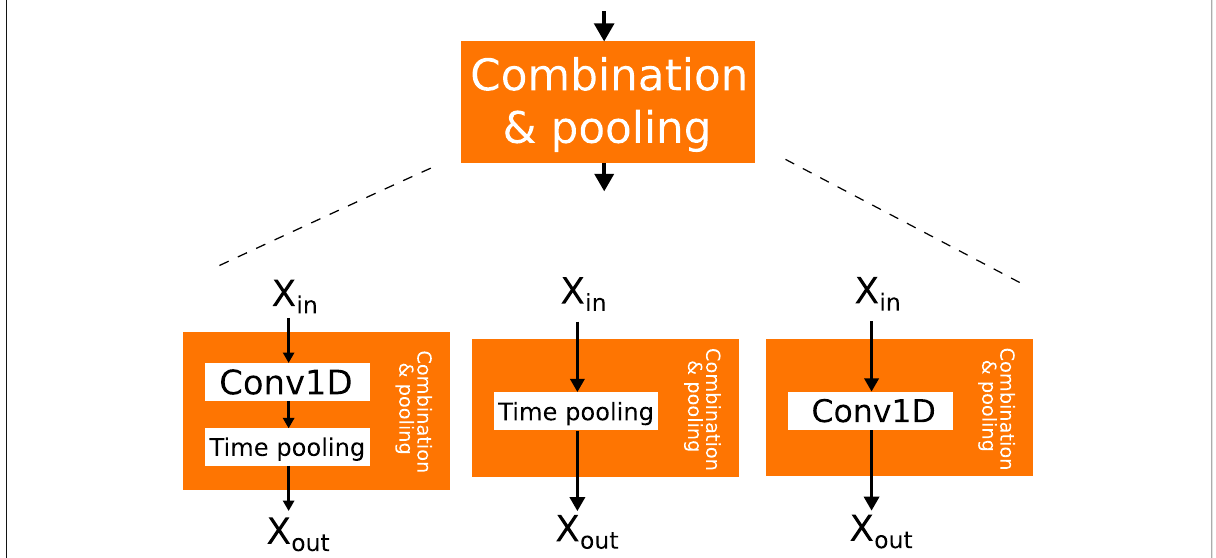
Fig. 2 Description of the proposed “Combination and Pooling” block and its three variations in this